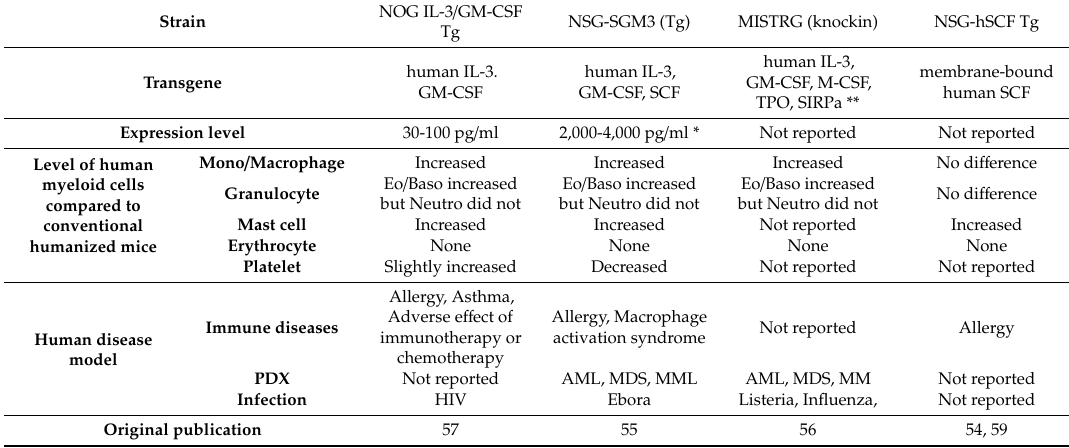
Table 1. Specifications of second-generation humanized mice and myeloid lineage differentiation